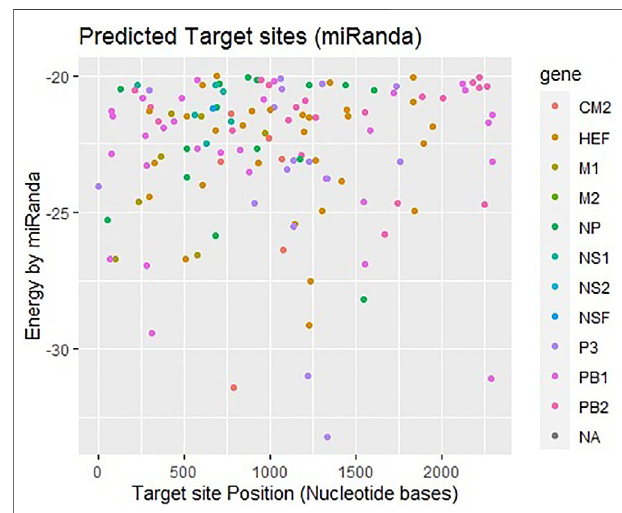
FIGURE3| Target sitesformiRNAsbindingtoin fl uenzaCvirusgenome predicted by RNA22 algorithm. The color dots represent binding to genes coding the relevant proteins. The gray dots labeled as NA which indicate non- applicable.